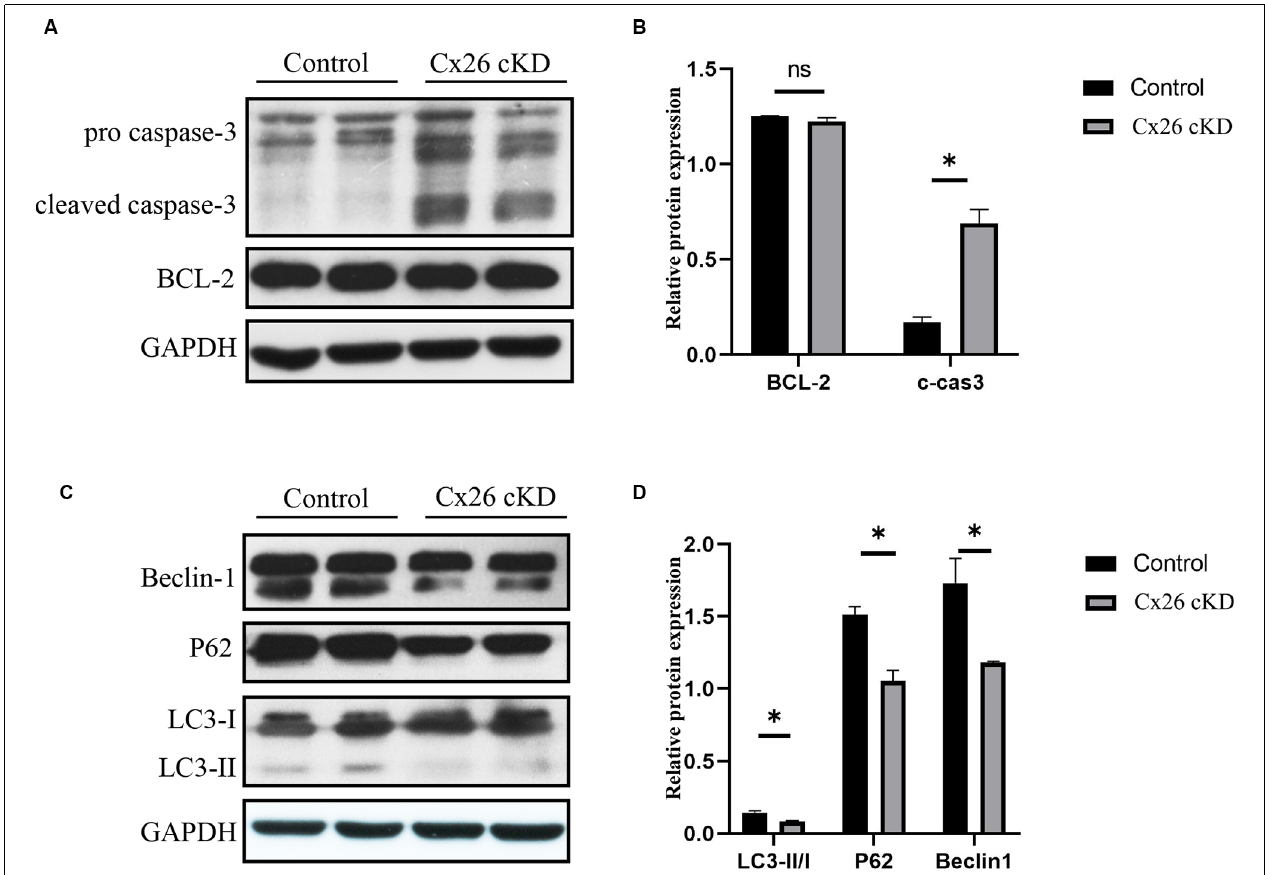
FIGURE 4 | Western blot analysis of apoptosis- and autophagy-related proteins in Kölliker’s organ at P1. (A) Representative western blots for apoptosis-related proteins Bcl-2 and c-caspase 3. (B) Corresponding relative optical density; ∗ represents P < 0.05, n = 5. (C) Representative western blots for autophagy-related proteins LC3-II, P62 and Beclin1. (D) Corresponding relative optical density; ∗ represents P < 0.05, n =